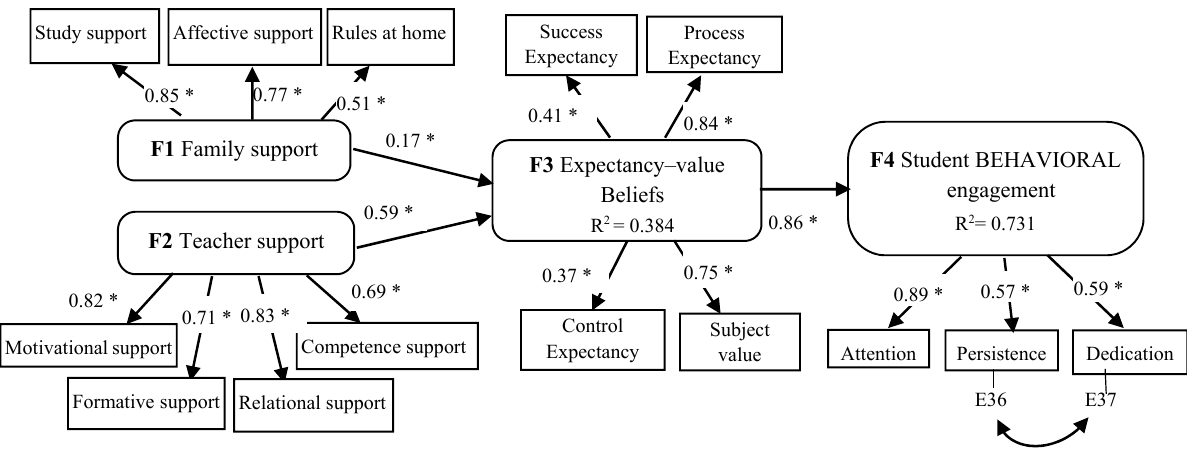
Figure 5. Optimized model (M1). Relation among teacher–family support, expectancy–value beliefs, and student behavioral engagement. The structural configuration and standardized coefficients of the optimized model are displayed.